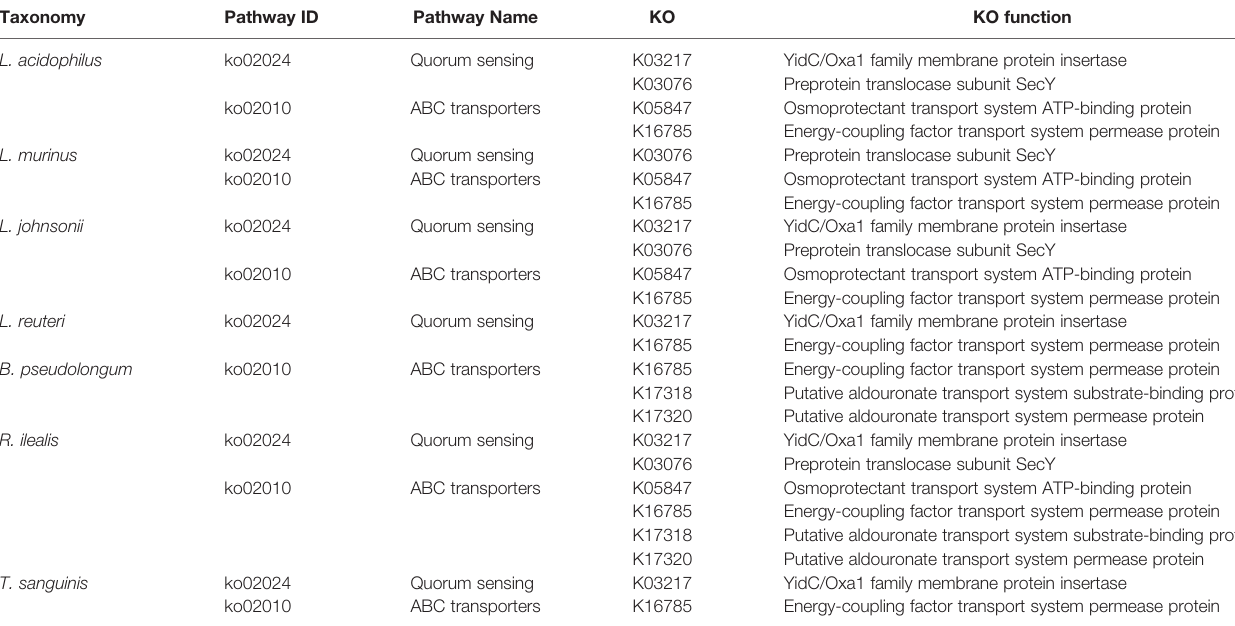
TABLE 1 | Association analysis of pathways with dominant functions and the top 10 species in the XFP group. Taxonomy